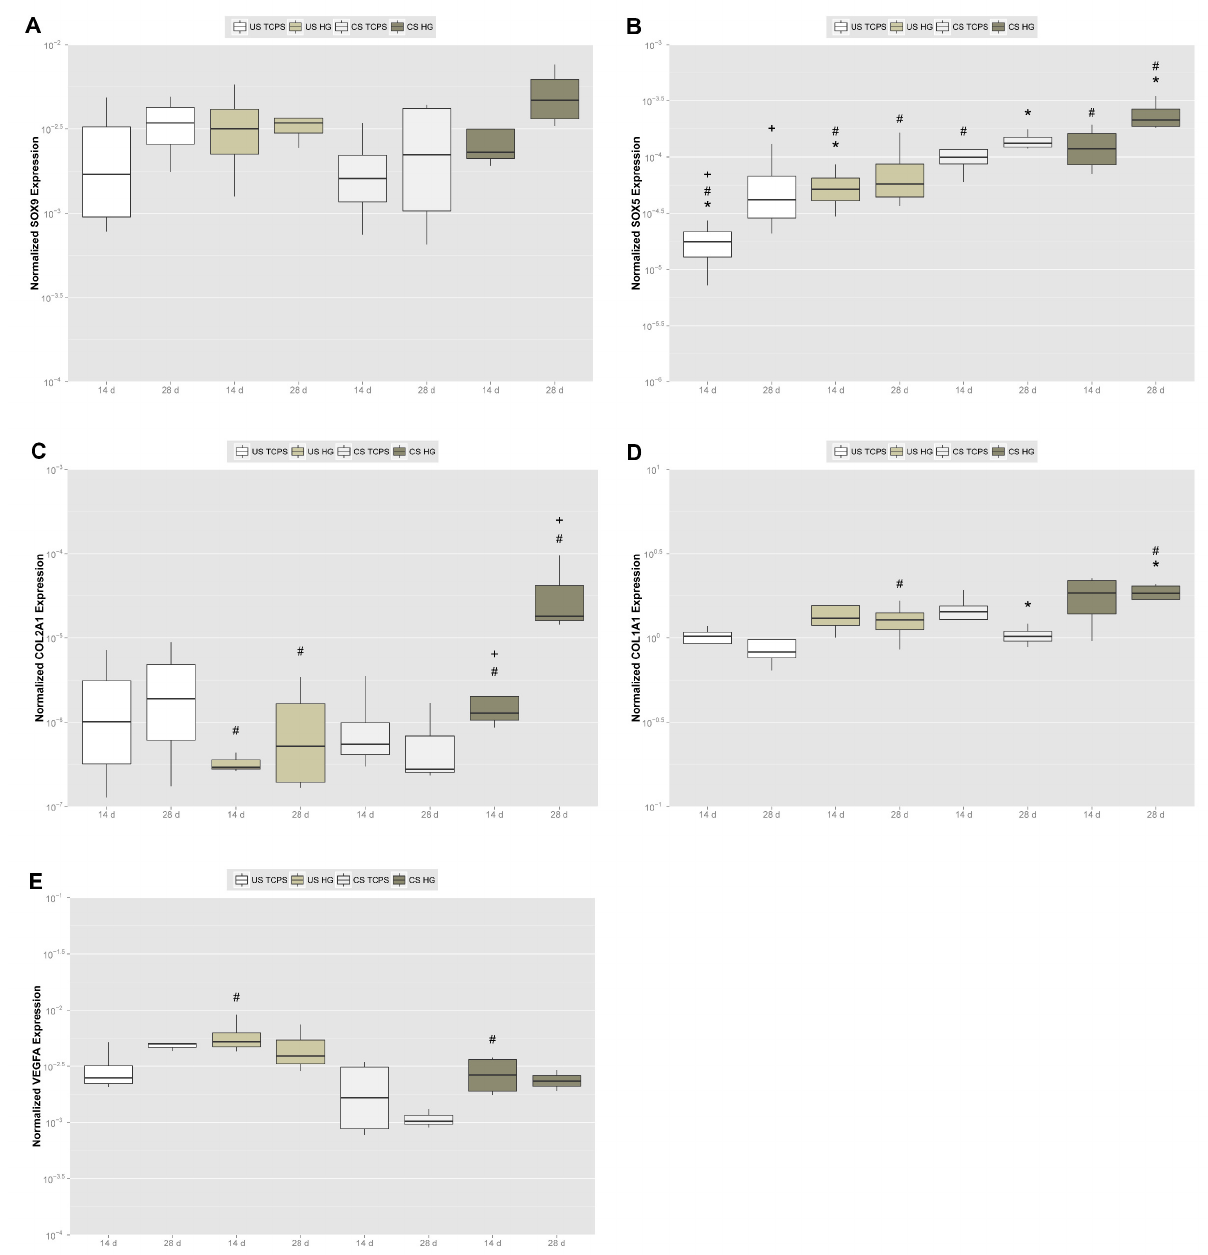
Figure 4. Analysis of chondrogenic marker gene expression by adMSC on hydrogels after 14 and 28 days of chondrogenic stimulation. Gene expression was analyzed by real-time RT PCR, normalizing to the expression of the beta actin gene ACTB . We analyzed expression of transcription factors sex determining region Y box 9 ( SOX9 ) and 5 ( SOX5 ) (subfigures ( A ) and ( B ), respectively), collagen type II, alpha 1 ( COL2A1 ) and type I, alpha 1 ( COL1A1 ) (subfigures ( C ) and ( D ), respectively), and vascular endothelial growth factor A ( VEGFA ) (subfigure ( E )). Mann-Whitney U test, p ≤ 0 . 05 . * TCPS significantly different to HG, # US significantly different to CS, + 14 days significantly different to 28